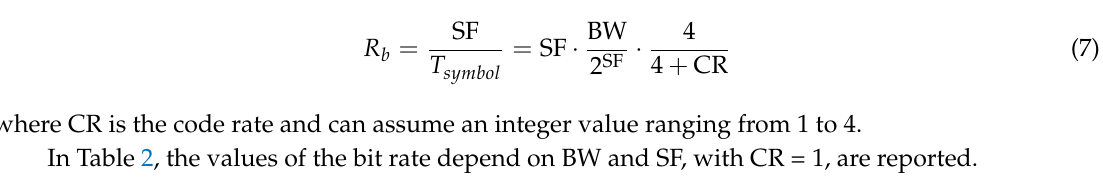
Table 2. Bit rate values depending on bandwidth (BW) and spreading factor (SF), with code rate (CR) = 1.